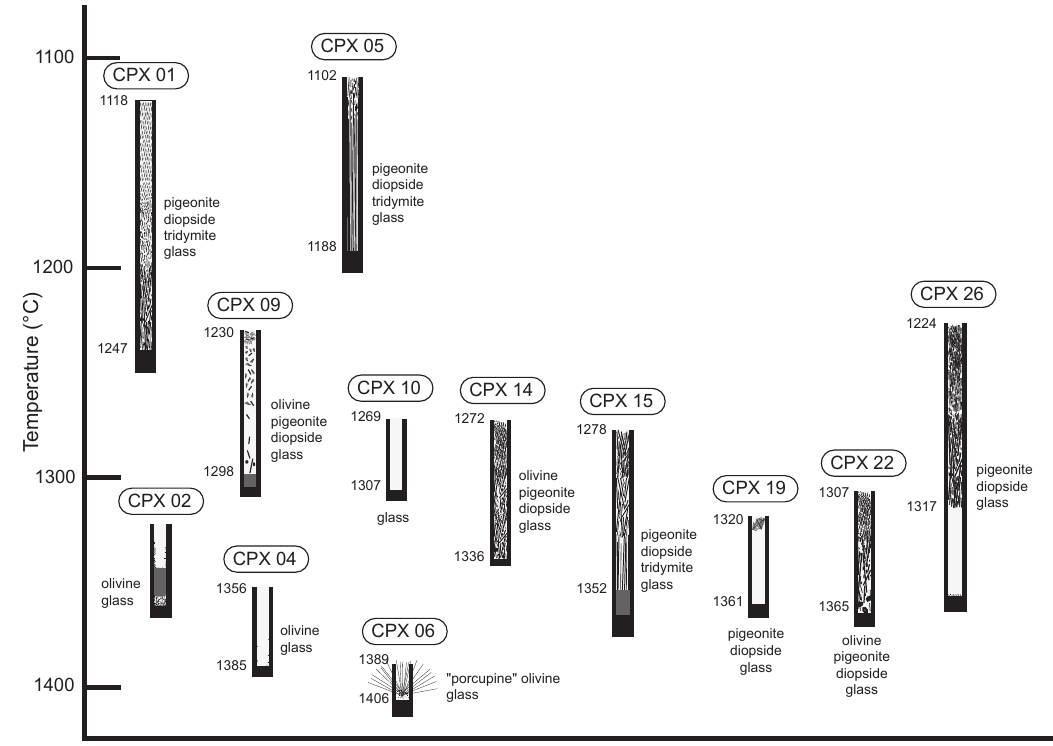
Figure 5. Textural and mineralogical data from dynamic crystallization experiments. The graphite capsules are represented in black. Minerals are in black and lie in a glass shown in white. Grey fields are